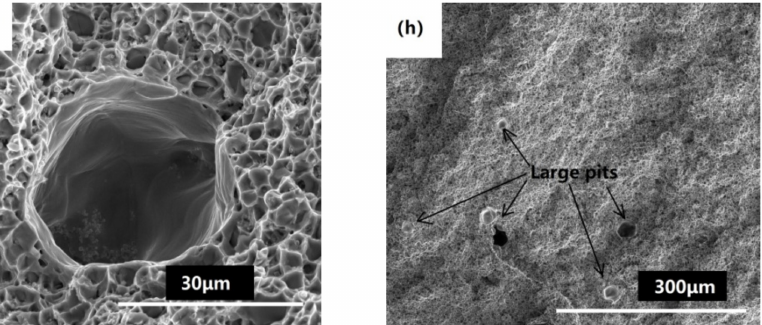
Figure 6. The fracture morphology of BSSs after heat treatment at ( a ) 900 ◦ C, ( b ) 1000 ◦ C, ( c ) 1050 ◦ C, ( d ) 1100 ◦ C, ( e ) 1150 ◦ C, ( f ) 1150 ◦ C, ( g ) 1200 ◦ C and ( h ) 1200 ◦ C of tensile